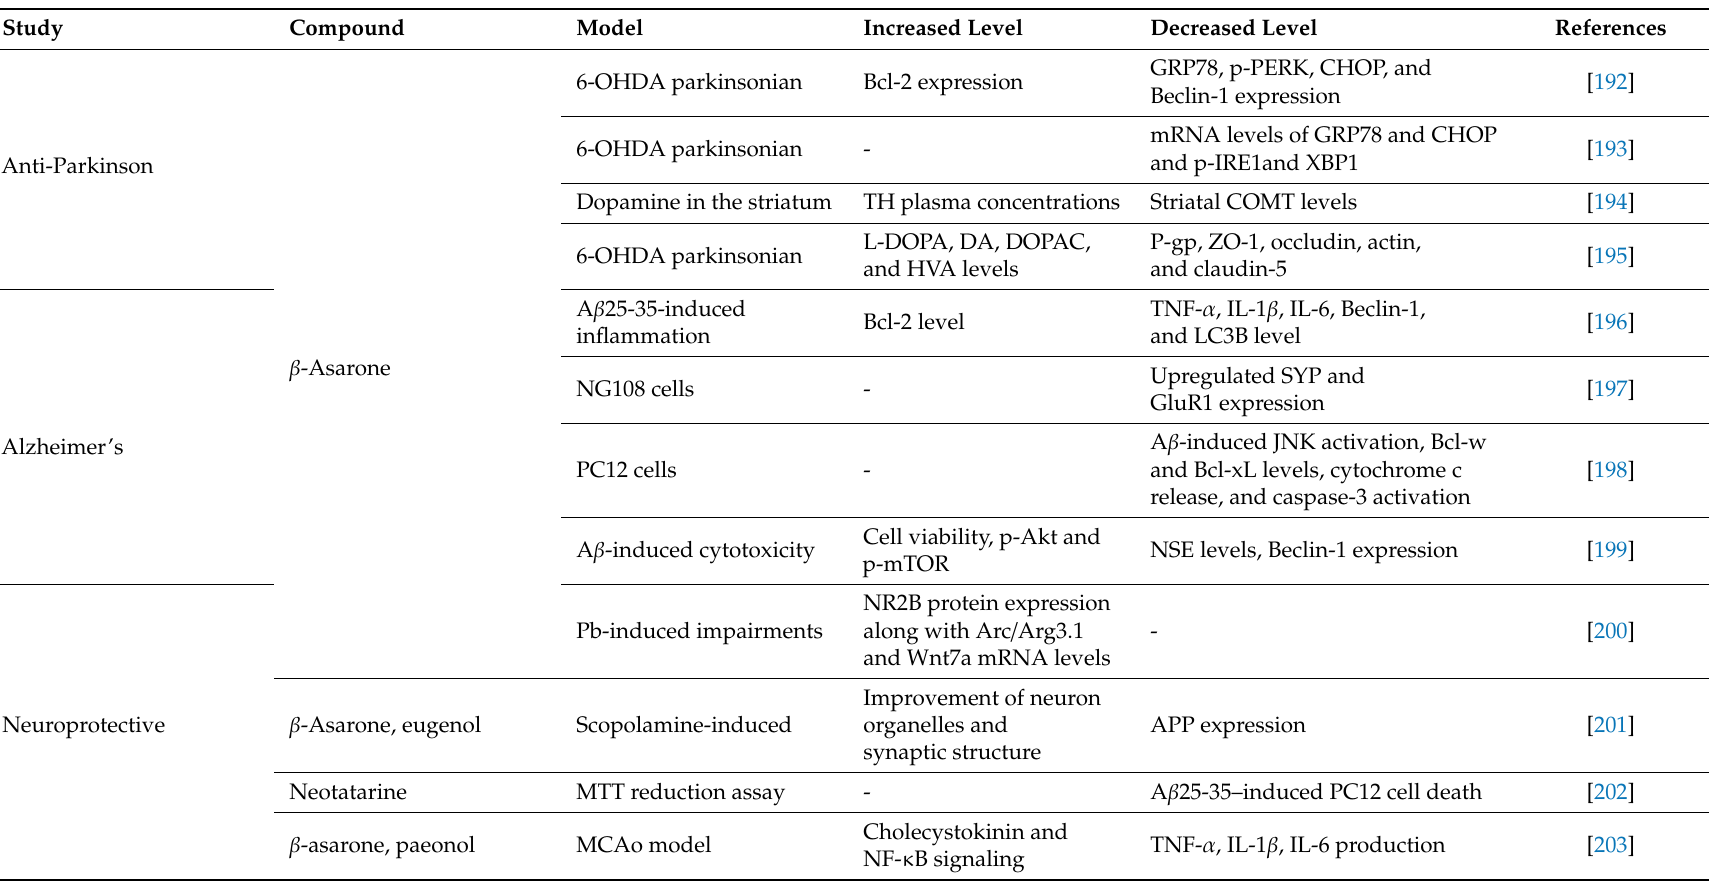
Table 6. Mechanistic role of phytochemicals of A. calamus in the treatment of neurological and metabolic